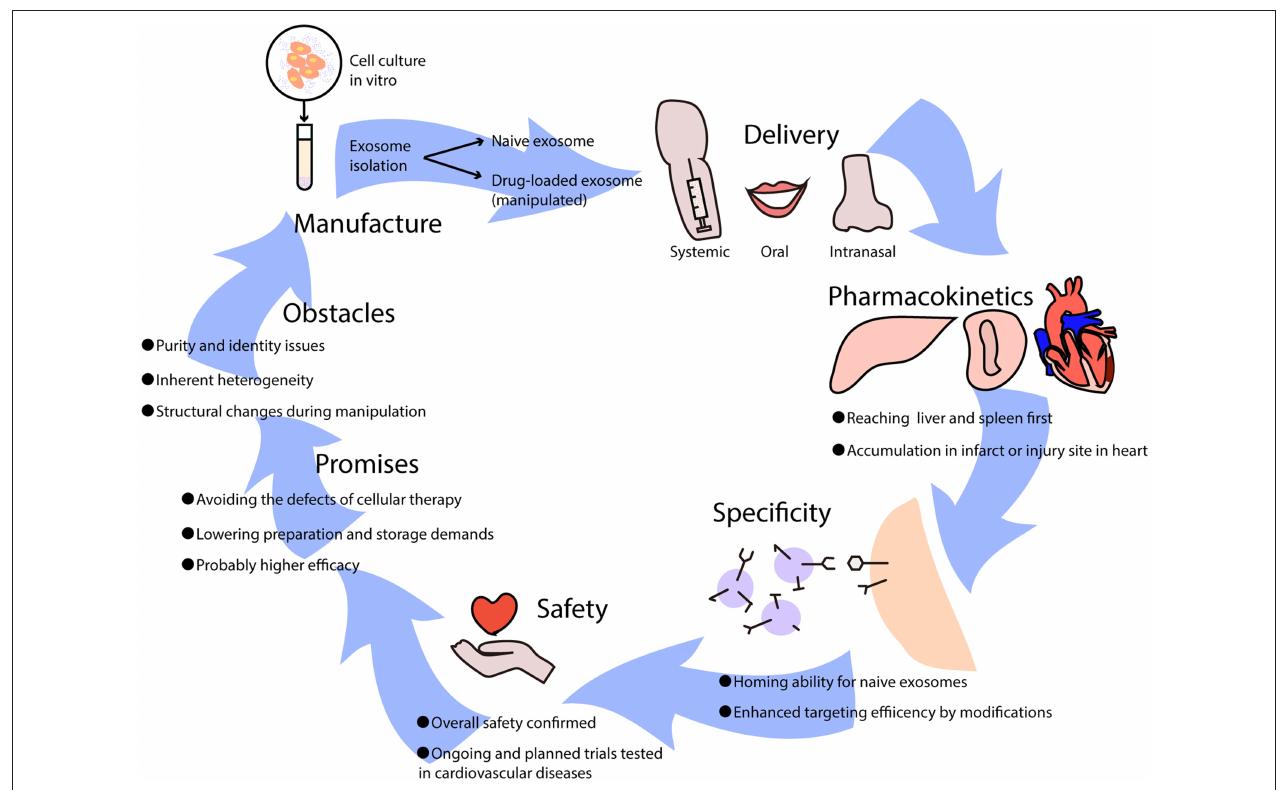
FIGURE 2 | The potential use of exosome-based therapies in cardiovascular diseases. Exosomes used as therapeutics are usually isolated from cell culture in vitro , which can be divided into naïve exosomes and drug-loaded exosomes that undergo artificial manipulation. Exosomes can be delivered into the body via intravenous (systemic) administration, oral administration, and intranasal administration, leading to different biodistributions and effects. When exosomes come into circulation, they first reach the liver and spleen where monocytes are located, and they may be recruited to infarcts or injury sites in the heart. Some naïve exosomes possess homing abilities, while others lack a unique target and can be improved by adding modifications. It has been reported that exosome-based therapies are safe overall, though further clinical trials are needed to test cardiovascular diseases. Generally, the promises of exosome-based therapeutics are huge, avoiding the difficulties that cellular therapies have, lowering manufacture costs, and increasing efficacy in treating diseases. However, certain obstacles need to be resolved such as purity and identity issues, inherent heterogeneity, and structural changes during